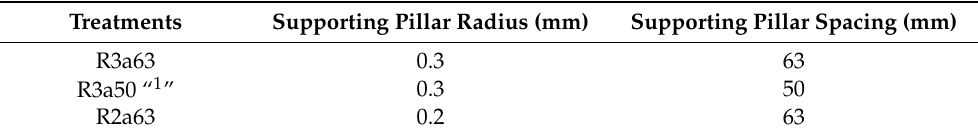
Table 3. Experimental design for ANSYS simulation. Treatments Supporting Pillar Radius